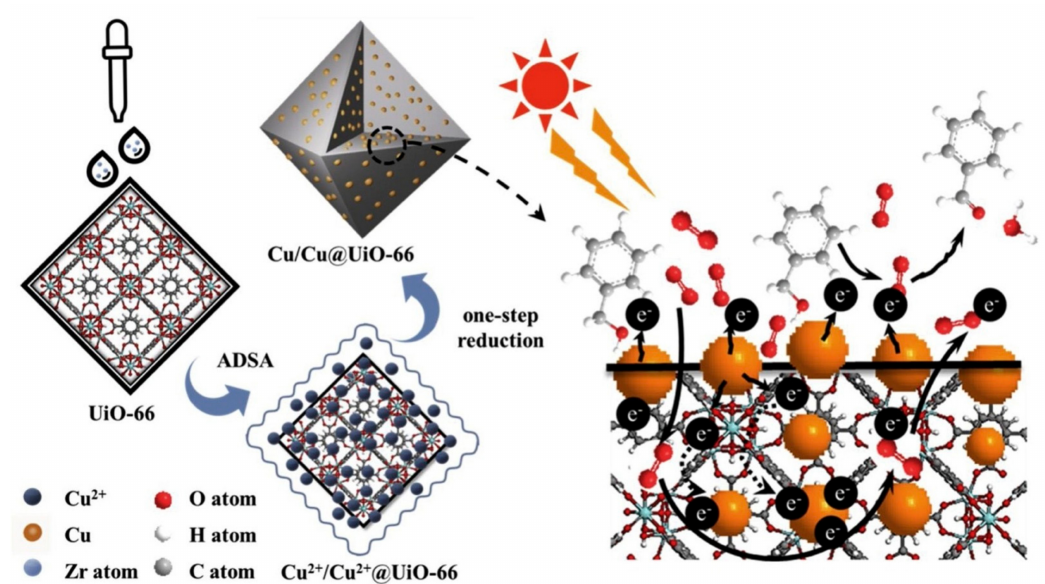
Figure 14. Scheme of the synthesis approach of Cu@UiO-66 composite and reaction mechanism for partial oxidation of benzyl alcohol under visible light irradiation. Adapted and reprinted with permission from [252], Copyright (2019)